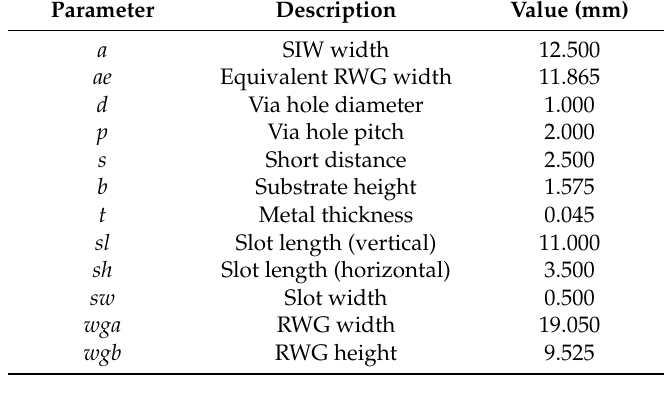
Figure 2. RWG-to-SIW transition simulated scattering parameters (no matching elements).